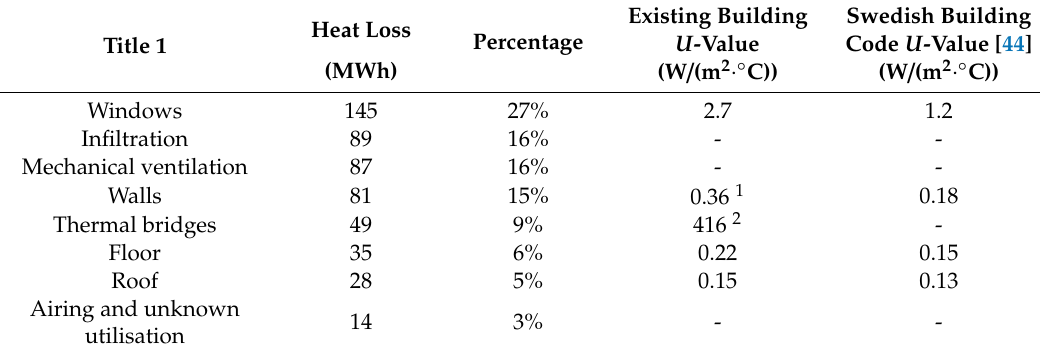
Table 9. Distribution of heat losses in heat balance, simulated during the heating season, 1 September to 31 May, with normalised climate